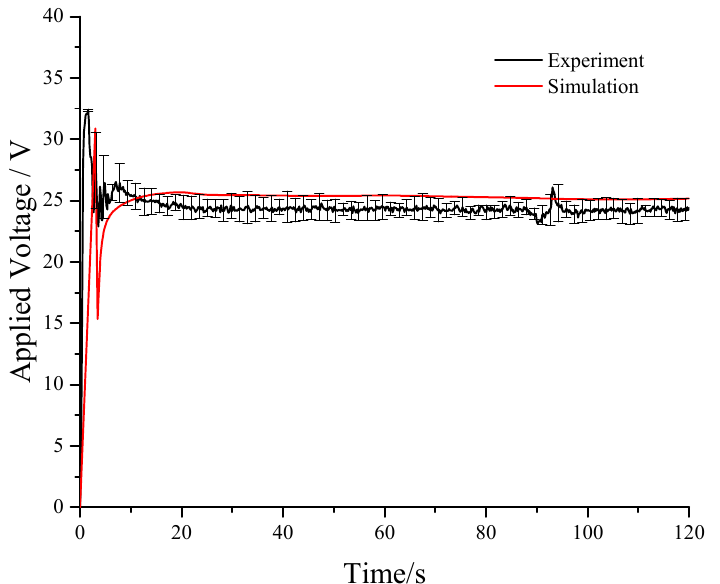
Figure A2. Comparison of the applied voltage in the experiment and simulations.